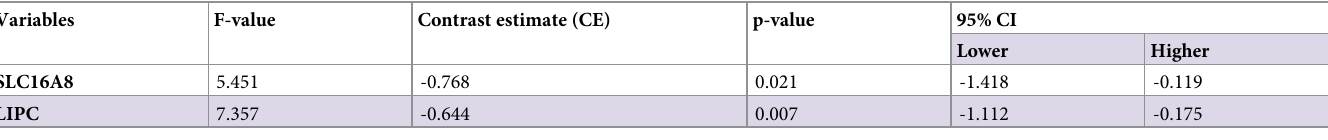
Table 5. Contrast estimate using univariate analysis of variance to differentiate the expression pattern on basis of gender for control population.